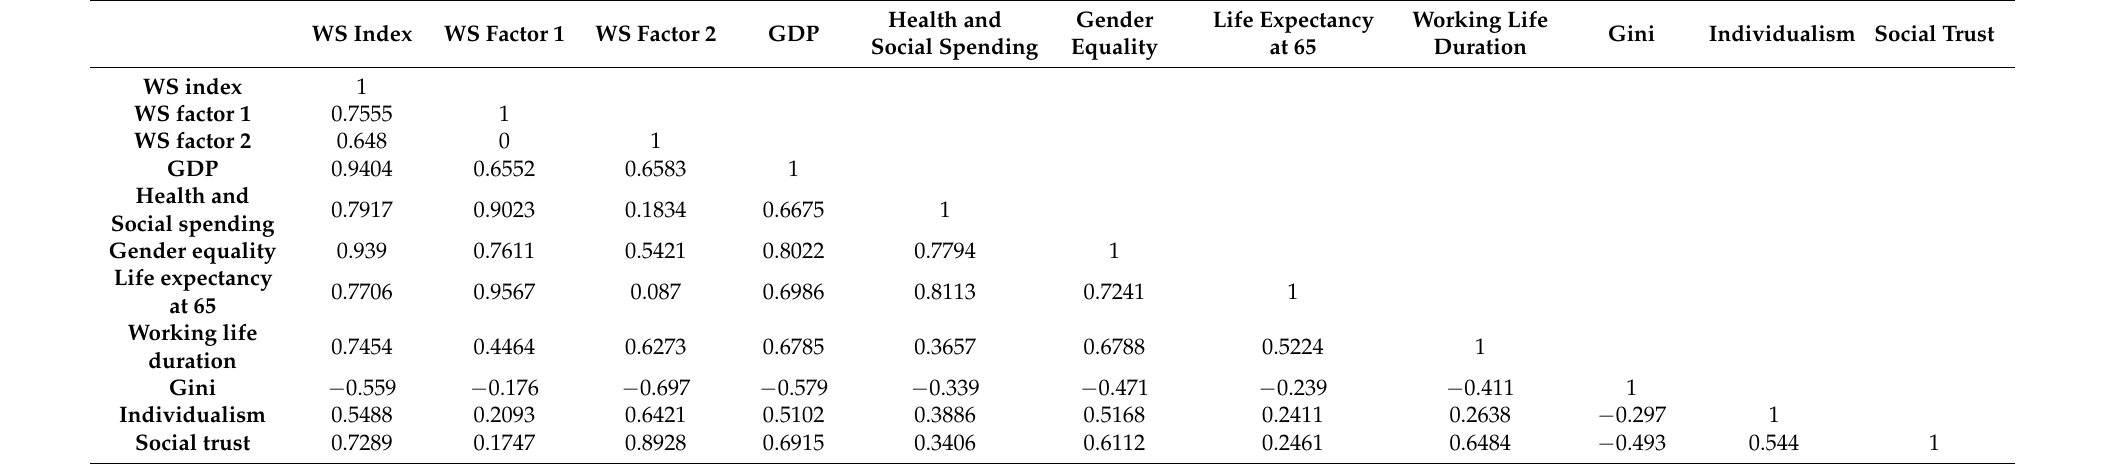
Table A6. Correlation matrix of the WS index and two WS factors and included